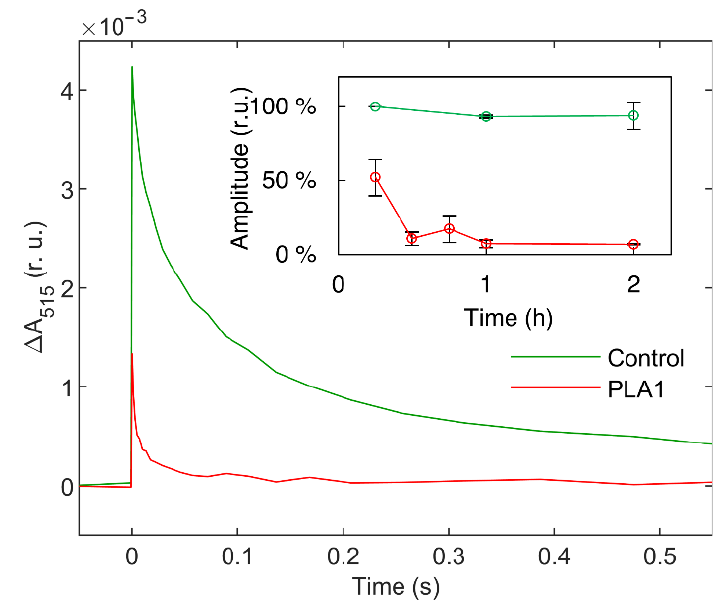
Figure 1. 31 P-NMR spectra of spinach thylakoid membranes; untreated (green) and treated with 2 U mL − 1 PLA1 for 15 (light red), 30 (red), and 60 (dark red) min. Spectra of three independent batches of isolated thylakoid membranes were averaged; the total acquisition times, at least 30 min for each spectrum; temperature, 5 ◦ C. Insets show the isotropic region (left-hand side) and the lipid phases outside the isotropic region (right-hand side). Spectra were normalized to total Chl contents of 10 mg mL − 1 and 15 min acquisition times.